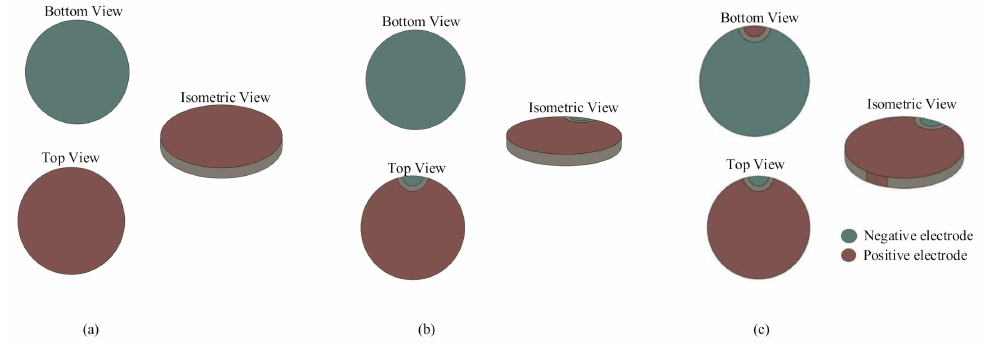
Figure 1. The structures of PZTs: ( a ) PZT-0; ( b ) PZT-1; and ( c )